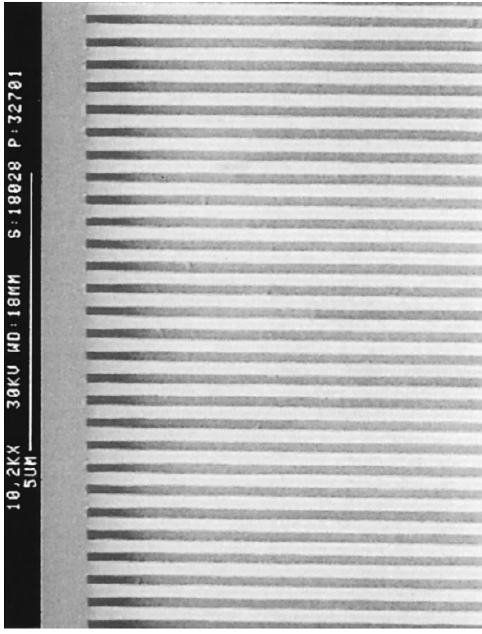
Figure 9. SEM image of the dielectric grating.